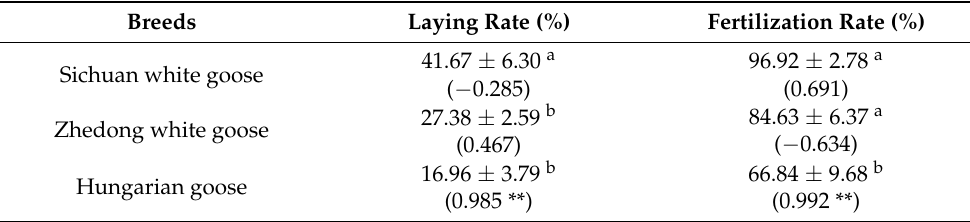
Table 4. Correlation between successful copulation and reproduction